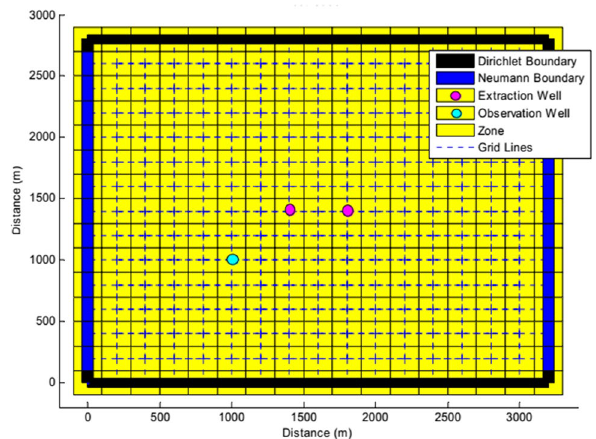
Fig. 4 Schematic of aquifer modeled for the validation of FEM